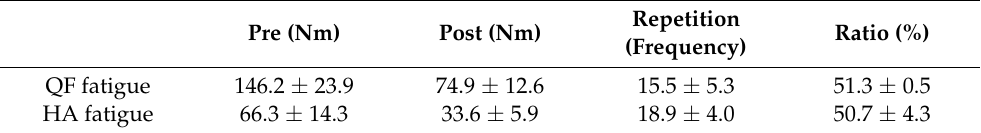
Table 1. Results of quadriceps (QF) and hamstring (HA) fatigue